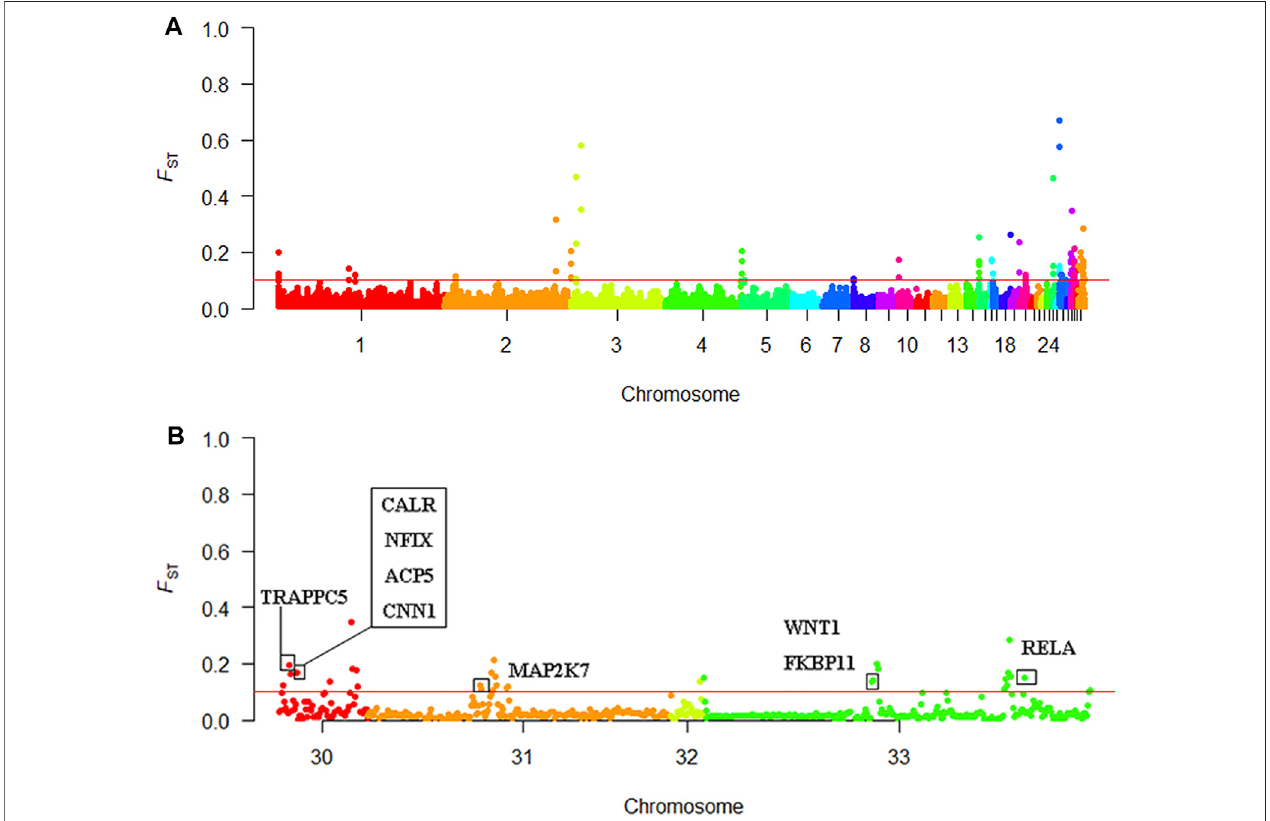
FIGURE 6 | Selective sweep analysis results (A) Manhattan plot of the F ST results (B) Manhattan plot of chromosomes 30 – 33.